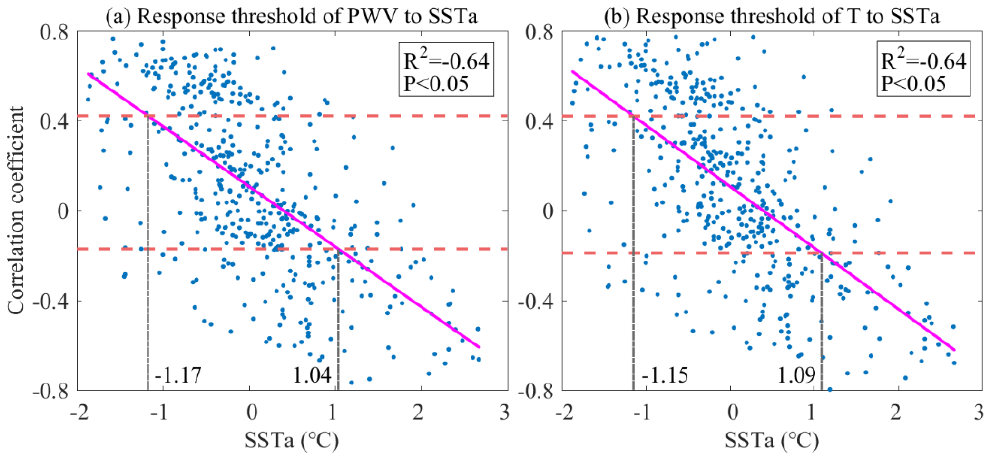
Figure 5. Scatter plots between correlation coefficients of PWV-SSTA/T-SSTA and SSTA in Southeast China over the period of 1979 – 2017. China over the period of 1979 –